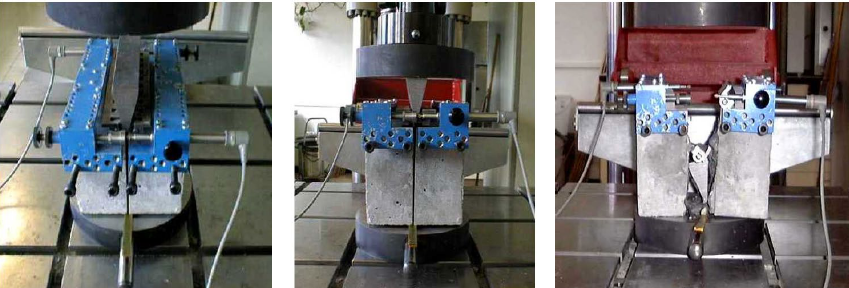
Figure 4. Test arrangement: at left the wedge is seen in the whole concrete cube extension; at the center it is seen the vertical notch; at right it is seen the fractured concrete cube.